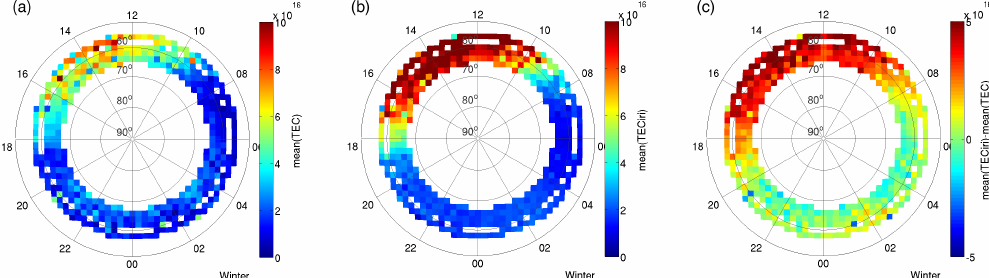
Figure 8. Magnetic local time mean values for winter time tomographic VTEC, corresponding IRI-2012 values and the difference between the two.